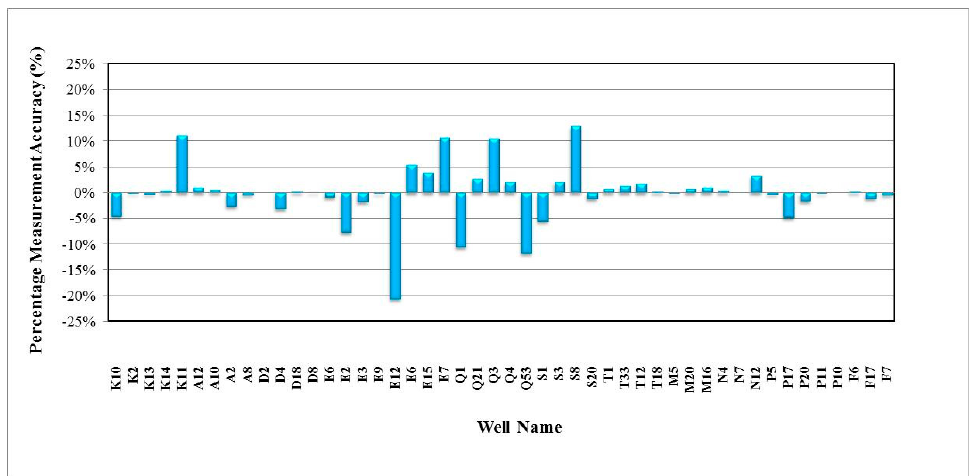
Figure 17. Oil rate measurement accuracy using the Blasius correlation.